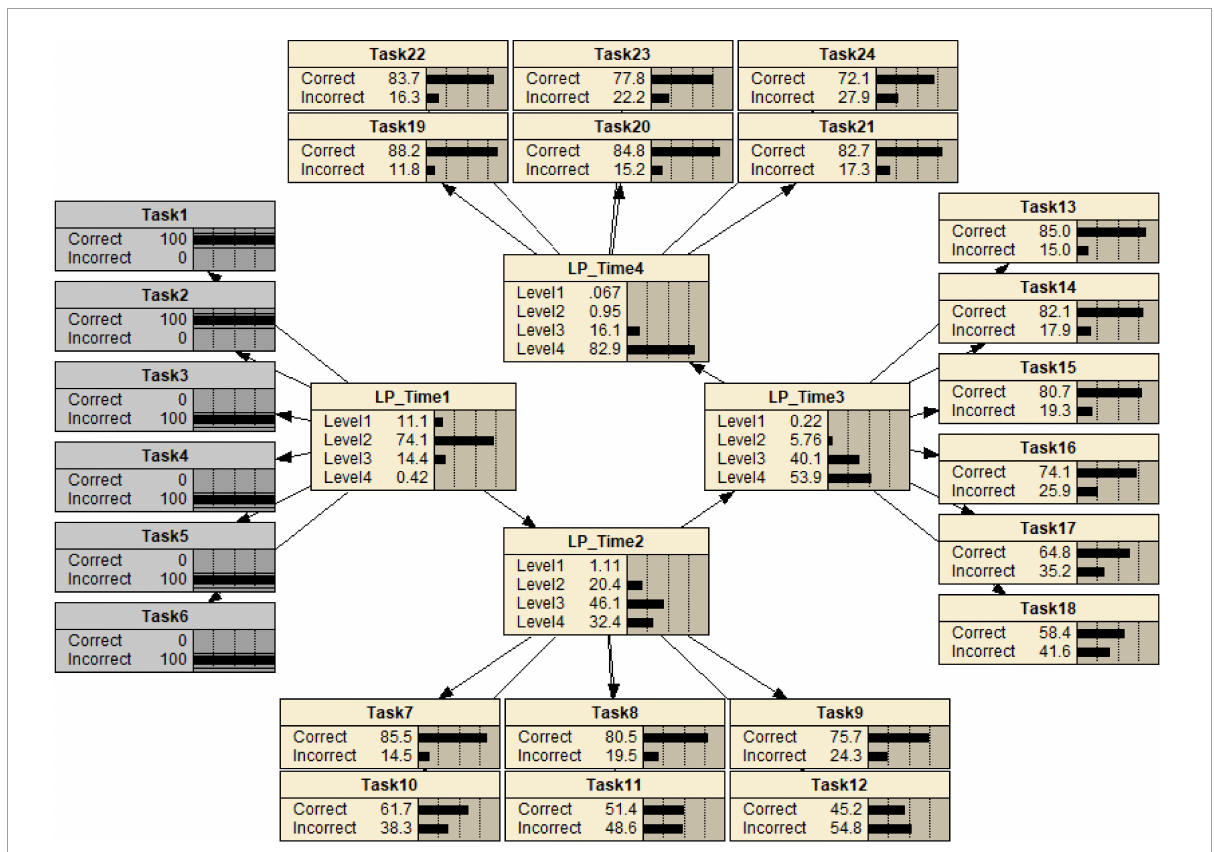
FIGURE4 A representation of the DBN when the student has the particular response pattern given 6 tasks at the first measurement